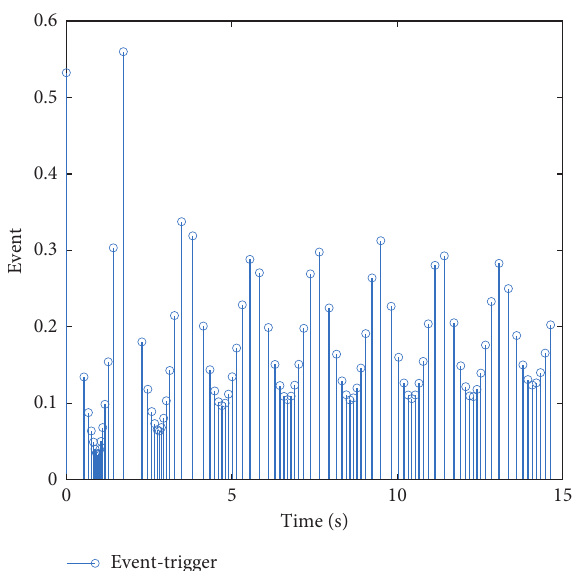
Figure 6: Event interval during deception attack